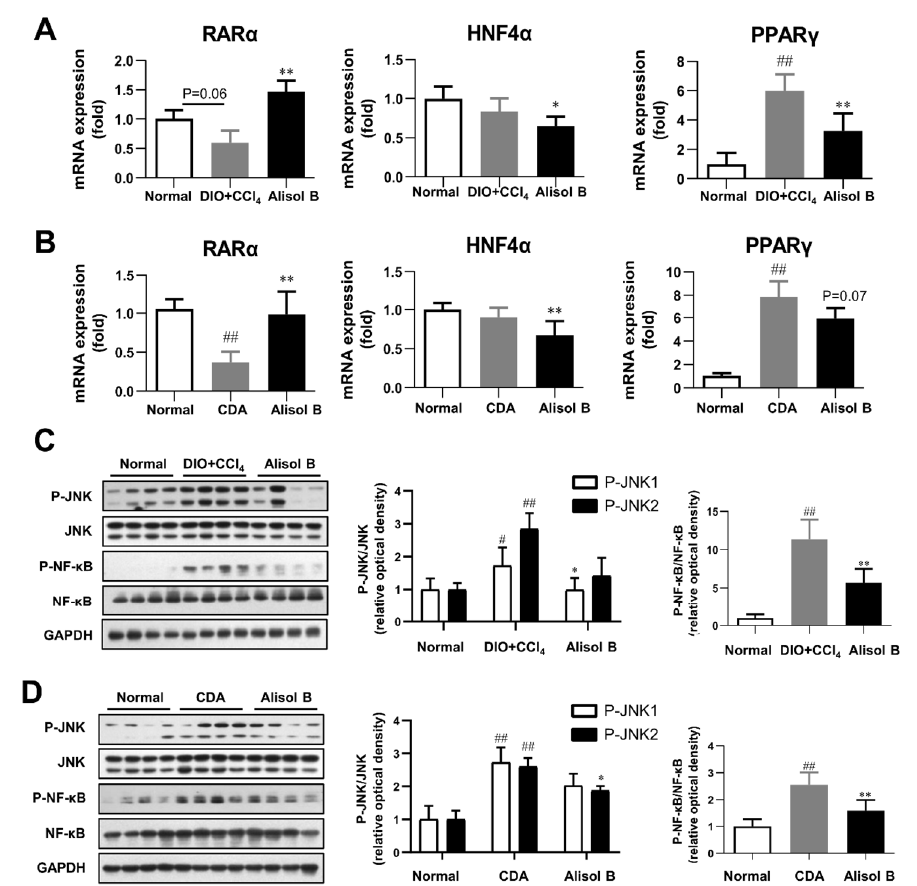
Figure 8. Alisol B regulated RAR α -mediated transcriptional cascade and inhibited JNK/NF- κ B signaling pathway in NASH mice. Hepatic mRNA levels of RAR α , HNF4 α , and PPAR γ were examined in ( A ) DIO+CCl 4 -induced NASH mice and ( B ) CDA diet-induced NASH mice. JNK1/2 and NF- κ B phosphorylation were detected in ( C ) DIO+CCl 4 -induced NASH mice and ( D ) CDA-diet-induced NASH mice. Data are expressed as mean ± SD, n = 8. # p < 0.05, ## p < 0.01 compared with the normal control group; * p < 0.05, ** p < 0.01 compared with the DIO+CCl 4 group or CDA group.